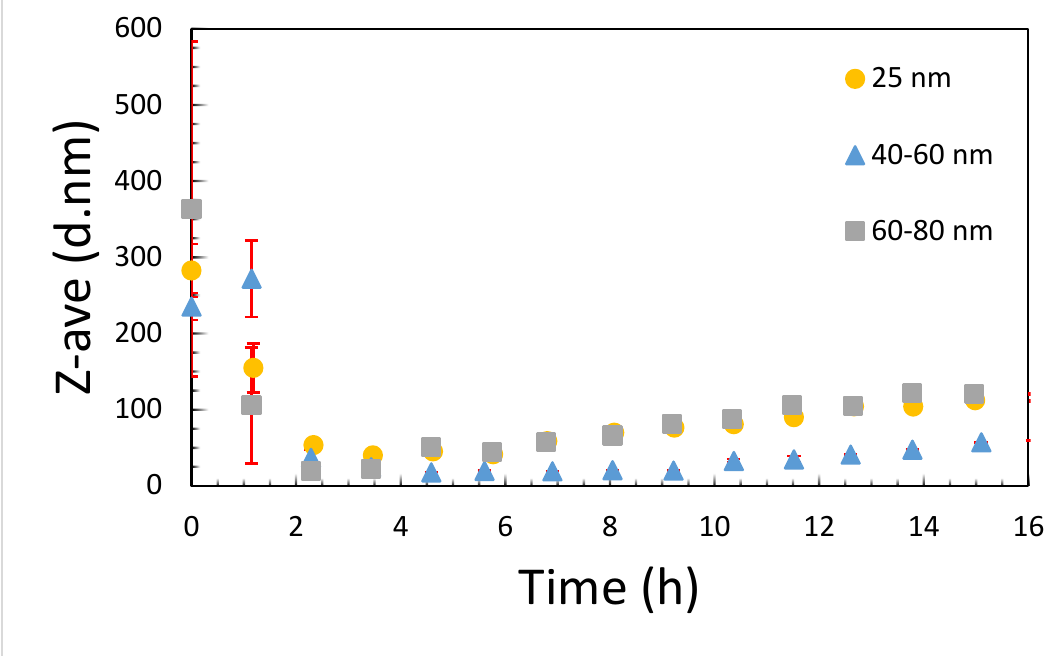
Figure 3. The Z-average diameter of 10 min bath-sonicated 20 µg/mL CuNP suspensions in media over a 16 h period with measurements made approximately every hour. After 16 h, no changes were ob- served out to 48 h.